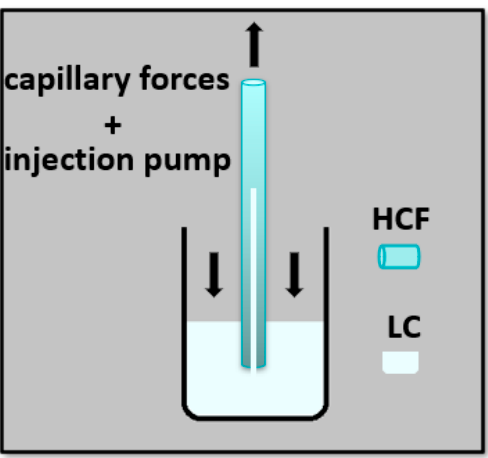
Figure 3. Schematic diagram for filling a liquid crystal into an HCF.